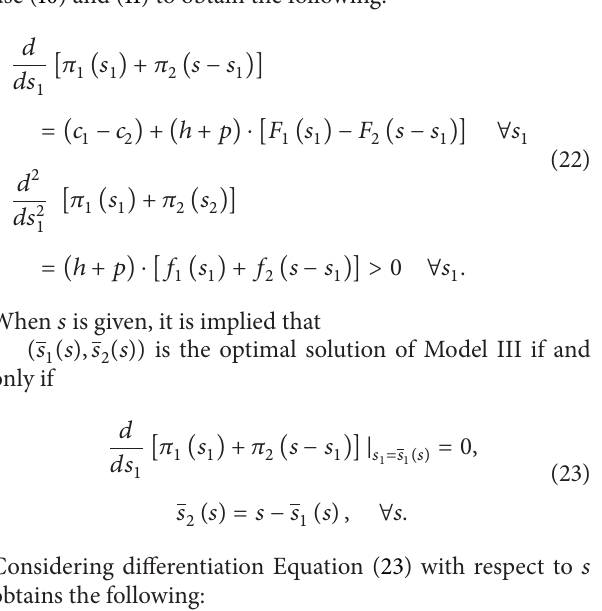
(25). From (11) and (12), 𝑠 ∗ 1 and 𝑠 ∗ 2 are, respectively, the only minima of 𝜋 1 (𝑠) and 𝜋 2 (𝑠) . Equation (25) can be used to obtain the only minimum (𝑠 ∗ 1 + 𝑠 ∗ 2 ) of 𝐺(𝑠) .